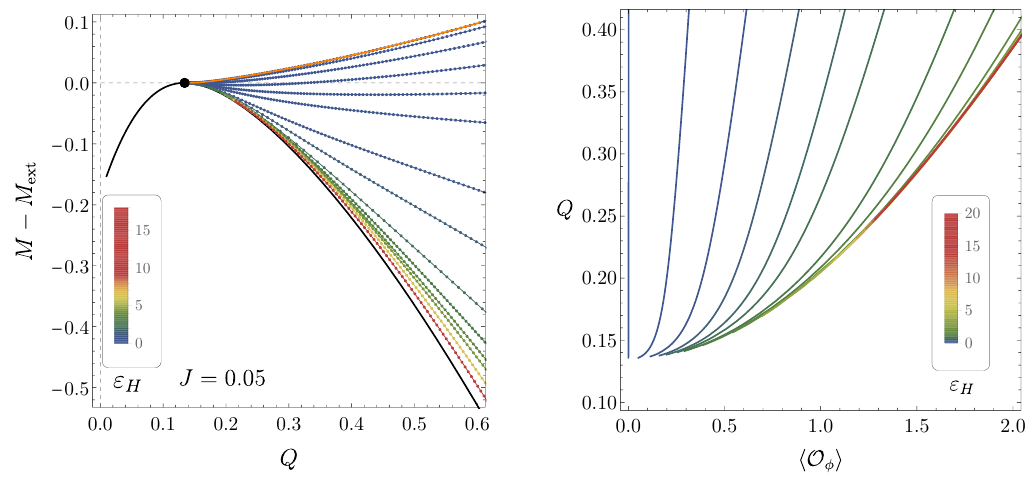
Figure 6 . Left : the mass di(cid:11)erence M (cid:0) M ext against the charge Q for (cid:12)xed angular momentum J = 0 : 05 and di(cid:11)erent values of the horizon scalar " H (rainbow disks), where M ext is the mass of the corresponding extremal CLP black hole with the same J and Q . The black disk shows the supersym- metric black hole, the grey solid line shows the BPS bound, the orange solid line shows the instability curve. Right : the charge Q against the expectation value of the operator dual to the scalar (cid:12)eld, for families of hairy black holes with constant J = 0 : 05 and various values of the horizon scalar " H